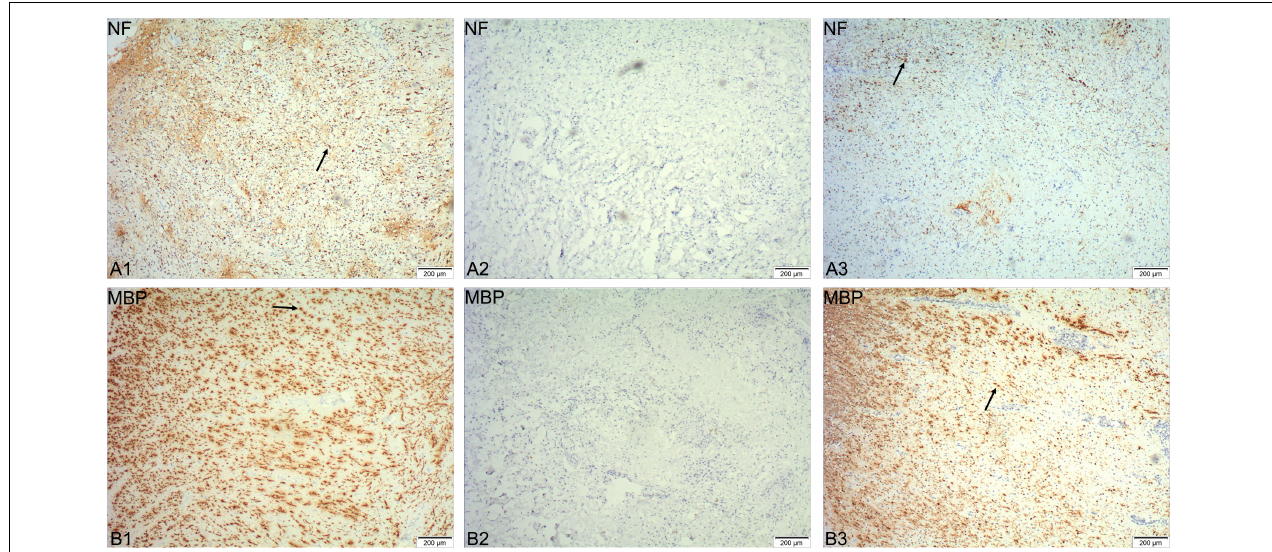
FIGURE 3 | Immunohistochemical staining of spinal cord tissue removed during the surgery. NF-200 positive axons and MBP-positive myelin sheaths can be observed at the distal and proximal ends of the tissue (arrows in A1,B1,A3,B3 ), but not in the center of the tissue (A2,B2) .